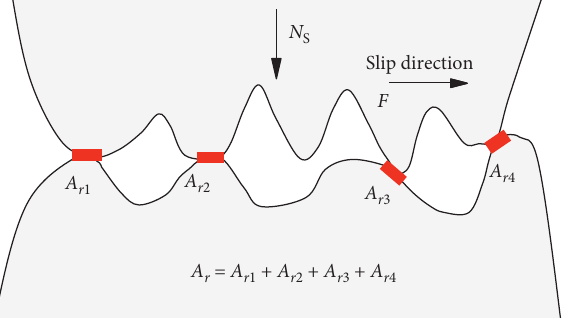
Figure 2: Schematic of intergranular contact